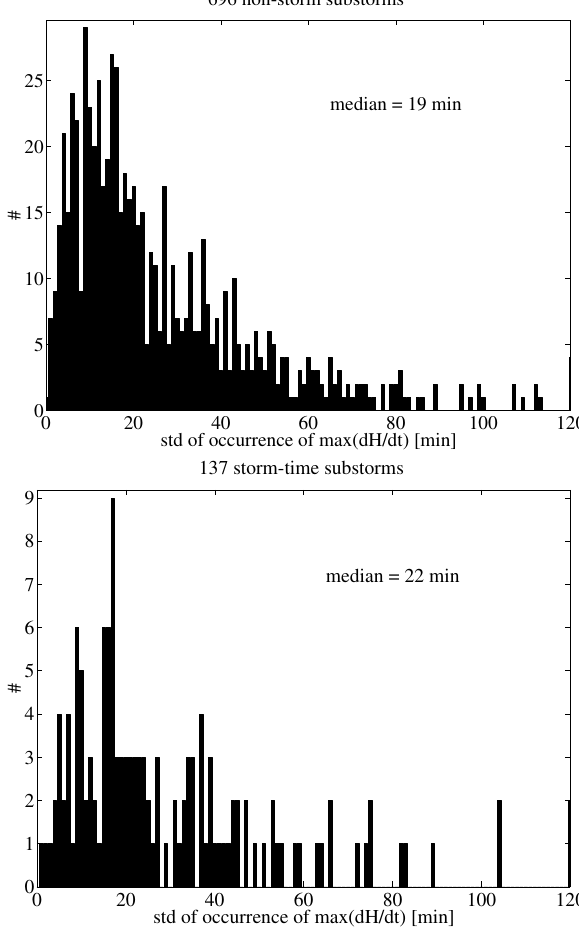
Fig. 5. The most probable time of max( | d H /dt | ) after the onset as a function of the CGM latitude. Upper panel: non-storm substorms, lower panel: storm-time substorms. A clear outlier is marked by a circle. Fig. 6. Simultaneity of the occurrence of max( j d H /dt j ) after the onset at the IMAGE sites. The histogram presents the standard deviation of the maxima times. Events with data from at least 15 stations are taken into account. Upper panel: non-storm substorms, lower panel: storm-time substorms.